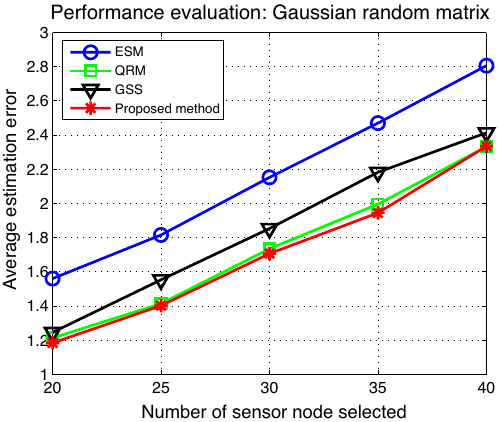
Fig. 1 Estimation performance with respect to various parameter dimensions for Gaussian random matrix H : the proposed algorithm is compared with different selection methods by varying the dimension of the parameter, | S | = p